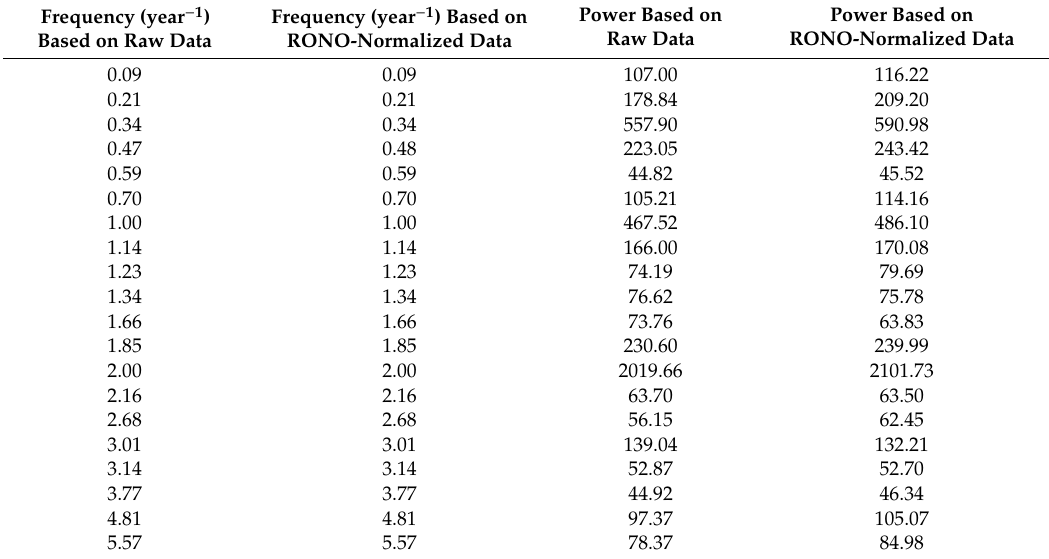
Table 1. The frequency and power of the top 20 peaks in power spectra formed from GSI night-time data for the frequency range 0–6 year − 1 , as computed from the raw (i.e., un-normalized) data and from the RONO-normalized